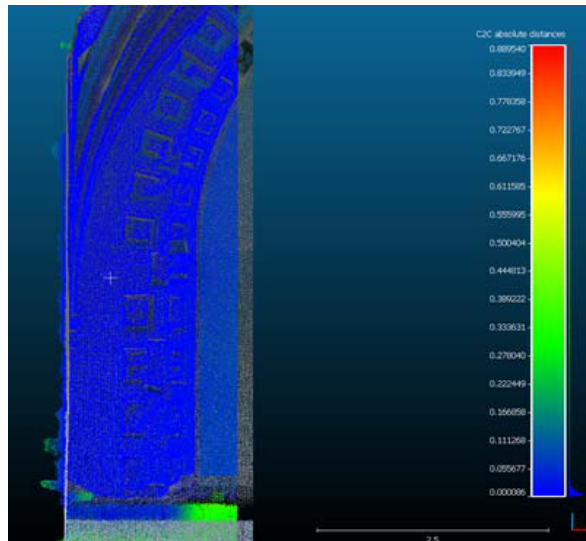
Figure 13: Crack location in wall: depth study and evaluation